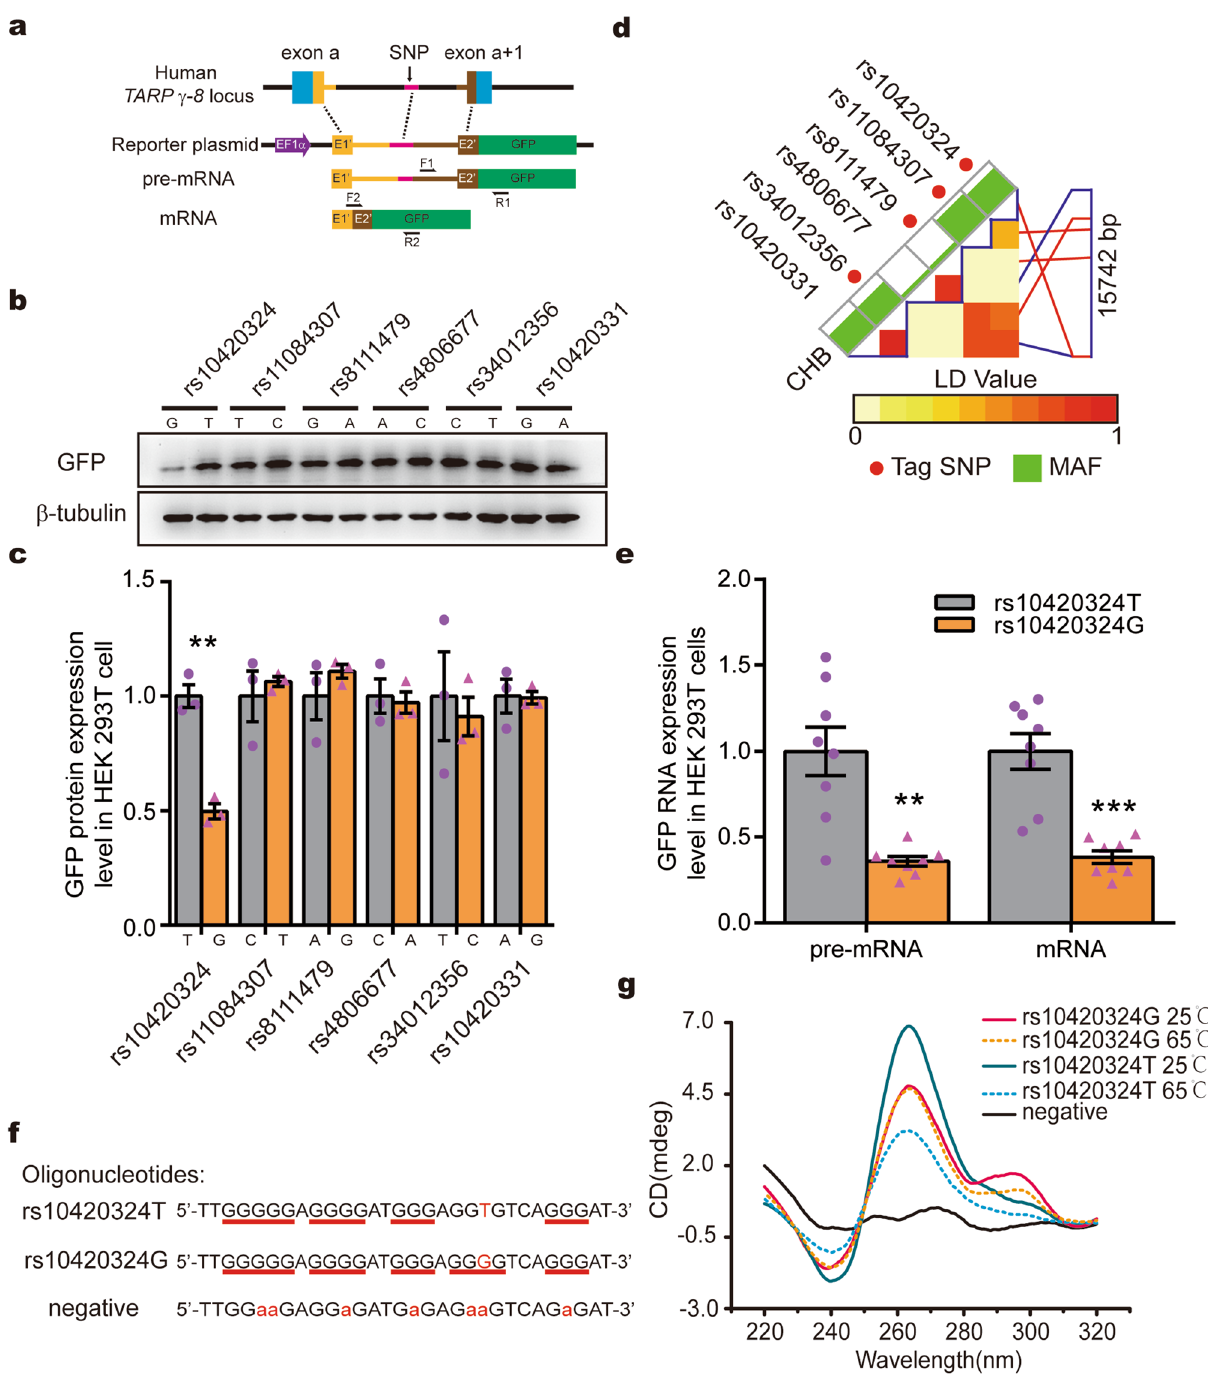
Figure 1. The rs10420324 SNPs regulate reporter gene expression by regulating the conformation and stability of a local G-quadruplex. ( a ) Schematic of the SNP fragment constructs inserted in the GFP reporter vector used in ( b , c , e ). The primers F1 and R1 were designed to examine pre-mRNA, while primers F2 and R2 were for mRNA. ( b ) Western blot analysis of GFP and β-tubulin protein in HEK 293 T cells transfected with the reporter plasmid. ( c ) Quantification of GFP expression levels. GFP expression was normalized using β-tubulin. ( d ) A linkage disequilibrium (LD) map for the TARP γ-8 gene was obtained from the SNPinfo web server, demonstrating a high LD value between the indicated SNPs. MAF: minor allele frequency. Red lines: Tag SNP location. Blue lines: SNP linked with Tag SNP location. ( e ) Fold change in GFP pre-mRNA and mRNA in HEK 293 T cells transfected with the reporter plasmid. GFP pre- mRNA and mRNA expression was normalized with β-actin. ( f ) Oligonucleotides containing the SNP rs10420324 were synthesized for CD spectral analysis. Underlined sequences indicate the guanine tandem repeats. An oligonucleotide with a G-rich sequence fragmented by guanine-to-adenine substitutions (in red) was used as a negative control. ( g ) CD spectra were measured in the presence of 100 mM KCl at 25 °C and 65 °C. The CD spectrum of the negative control was measured at 25 °C. Data represent the mean ± s.e.m. independent-sample t -test, * p < 0.05, ** p < 0.01, *** p <